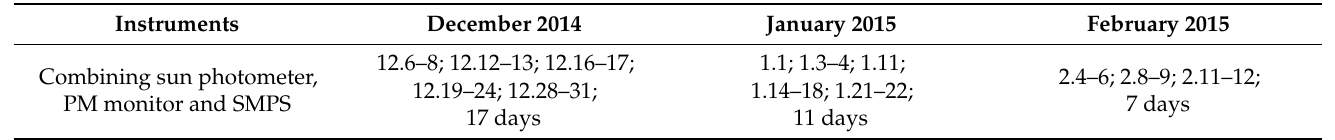
Table 1. Experimental data of the ground observation